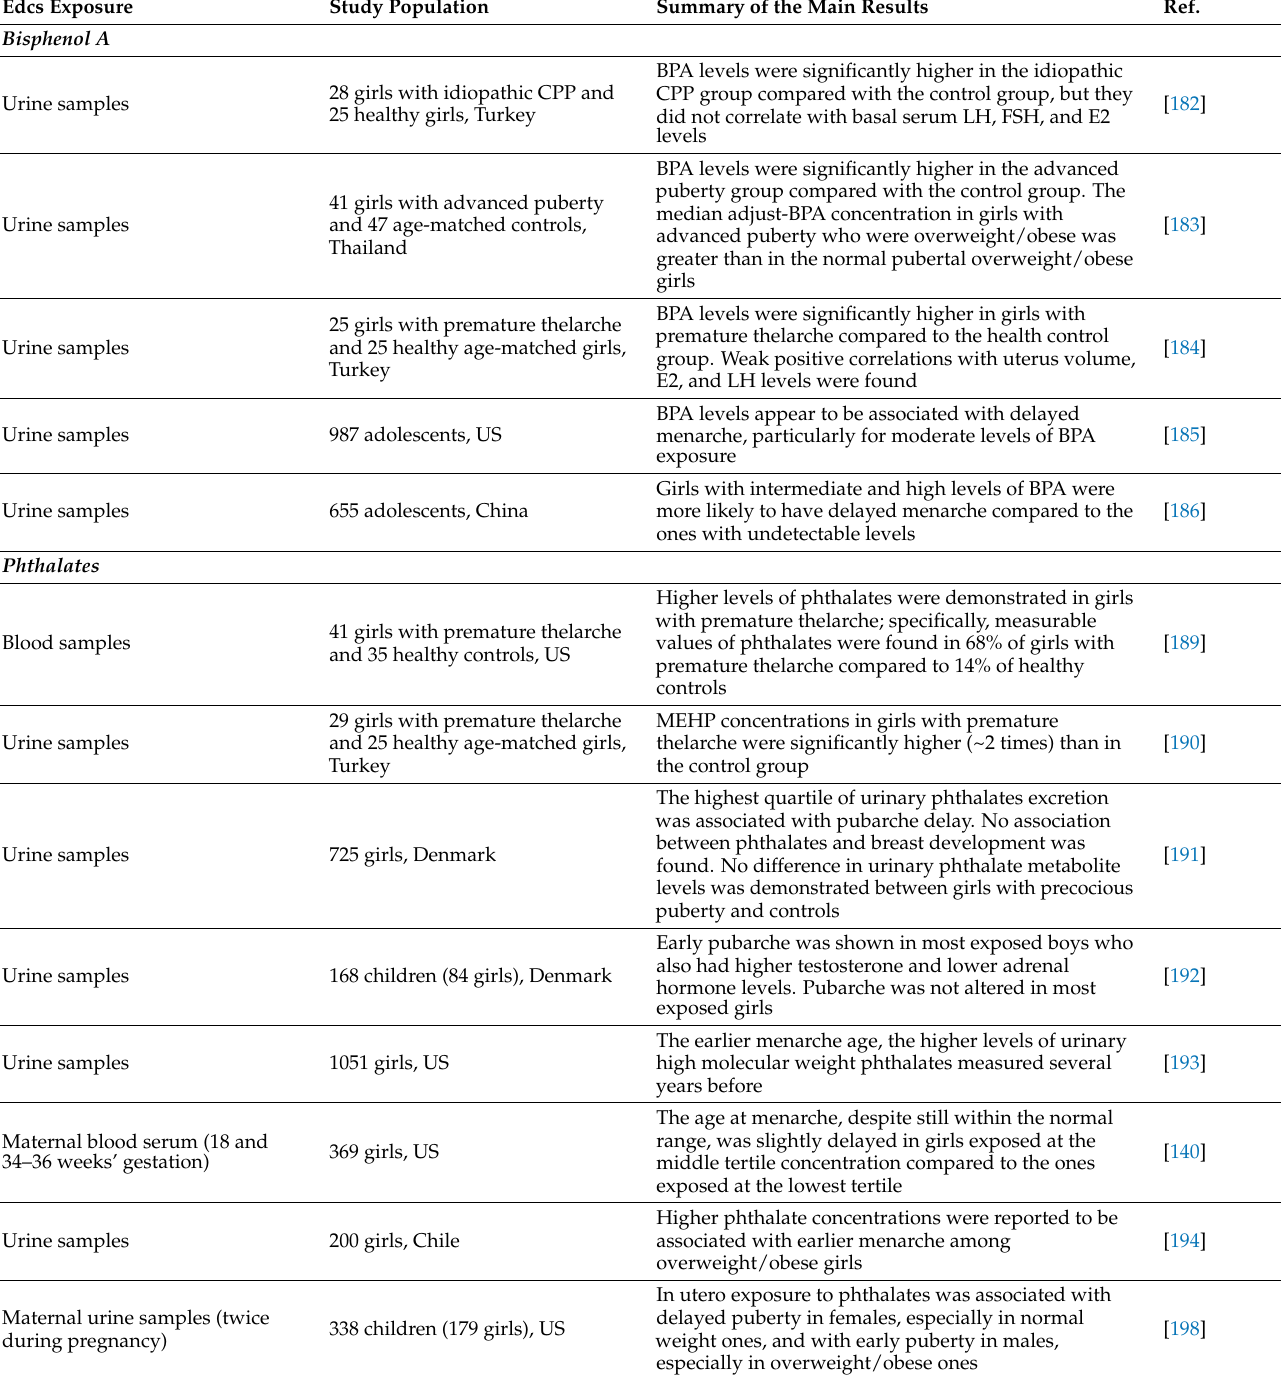
Table 5. Epidemiological data from some studies on pubertal